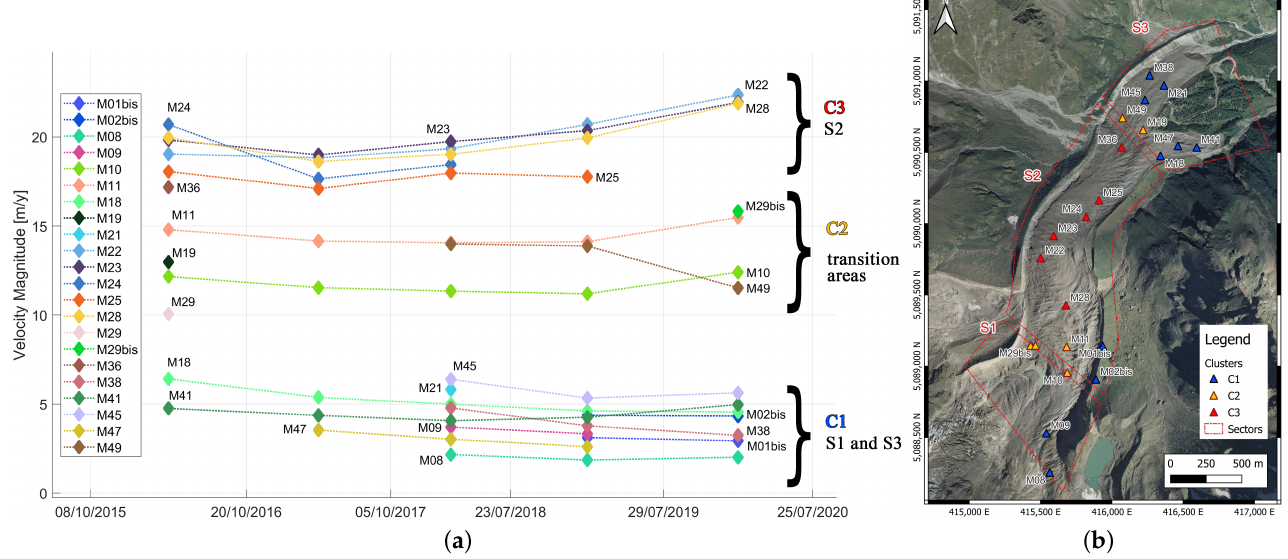
Figure 5. ( a ) Time series of the velocity computed from the GNSS measurements of the targets deployed over the glacier. Dashed lines denote measurement continuity over the years (i.e., if the line is interrupted, the target was lost or not measured during that year). Labels C1–C3 denote the three velocity clusters of GNSS points, whereas labels S1–S3 indicate the three morphological sectors marked in Figure 1a. A correspondence between clusters and sectors can be identified: C1 corresponds to sectors S1 and S2, cluster C3 to sector S2, whereas cluster C2 corresponds to the two transition areas S2–S1 and S2–S3. ( b ) Location of the targets over the glacier. The location accuracy of the GNSS measurement was estimated as ∼ 3cm (see Section